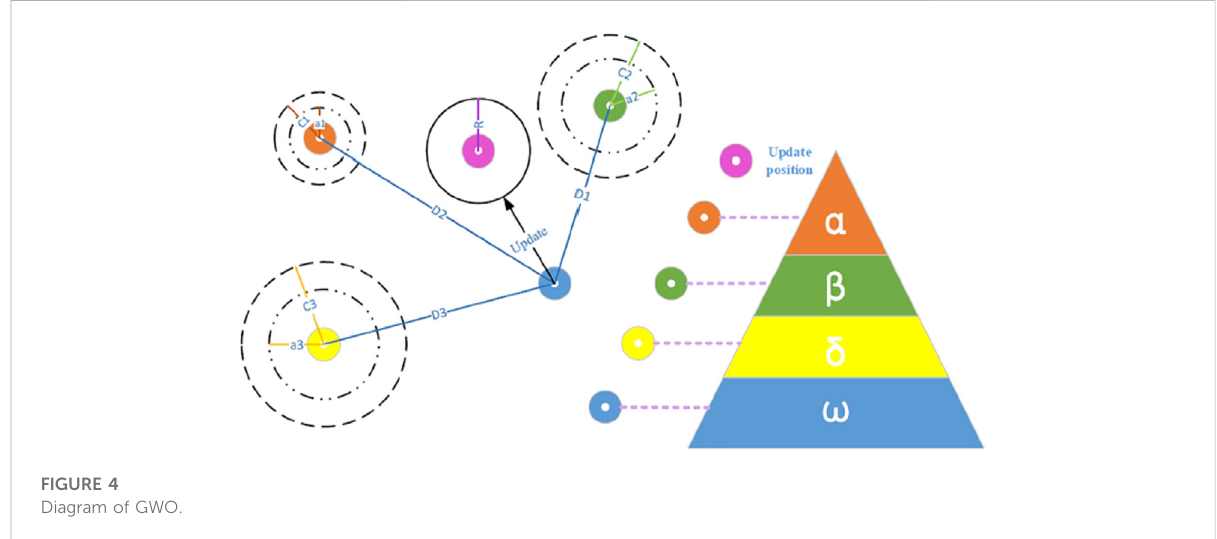
FIGURE 4 Diagram of GWO.